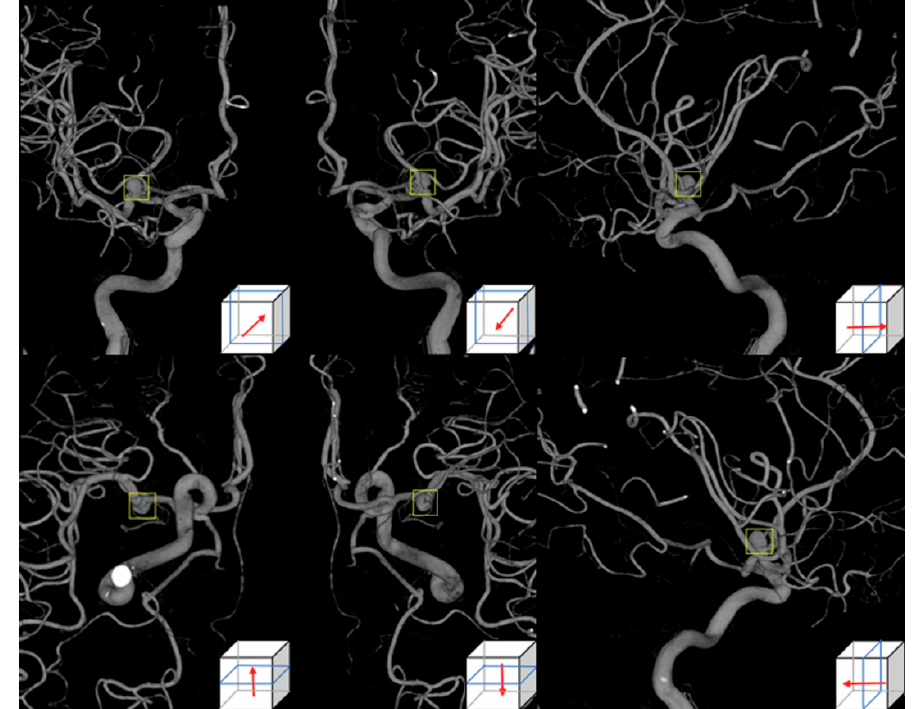
Figure 1. Aneurysm images using 3D-digital subtraction angiography in six directions, anteroposterior, posteroanterior, left lateral, superoinferior, inferosuperior, and the right lateral side. A user-selected region-of-interest shown as a yellow square was applied to each image.